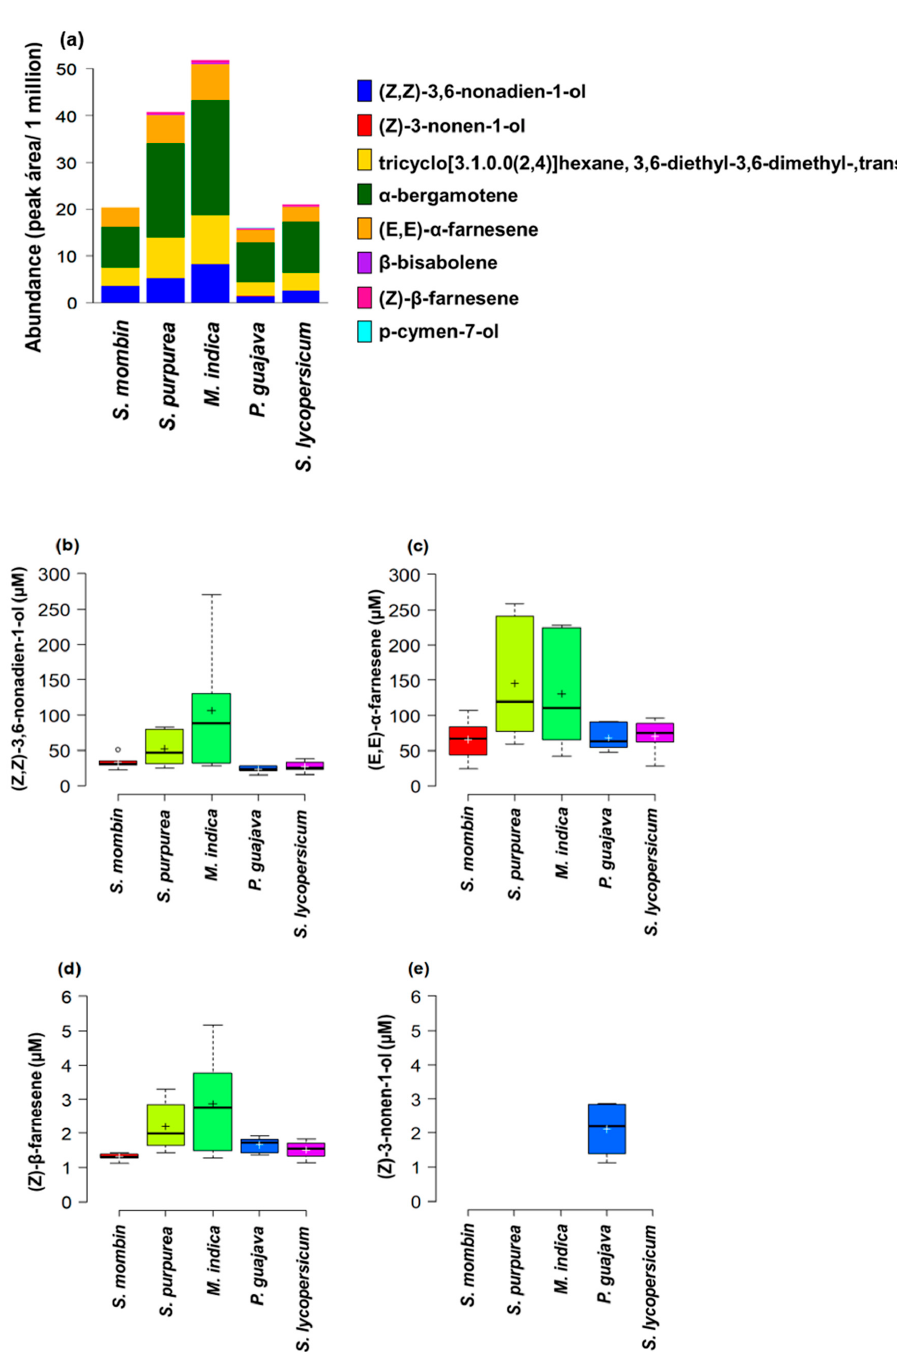
Figure 2. Chemical compounds identified in the e ffl uvia (scent bouquets) of sexually-mature calling A. obliqua males developed as larvae in di ff erent fruit. ( a ) The absolute abundance (peak area / one million) of the eight compounds tentatively identified by comparing mass spectra registered in the NIST library or confirmed with authentic standards. Note that the color bars of some compounds are extremely narrow and almost undetectable because such compounds were identified in very small abundances (the exact abundances of the eight compounds are available in Table S2). ( b – e ) Boxplots of the concentration of the compounds confirmed with authentic standards; the box shows the interquartile range and the horizontal line in each box the median, the whiskers indicate the minimum and maximum values, open circles indicate outliers, and the cross inside the box the